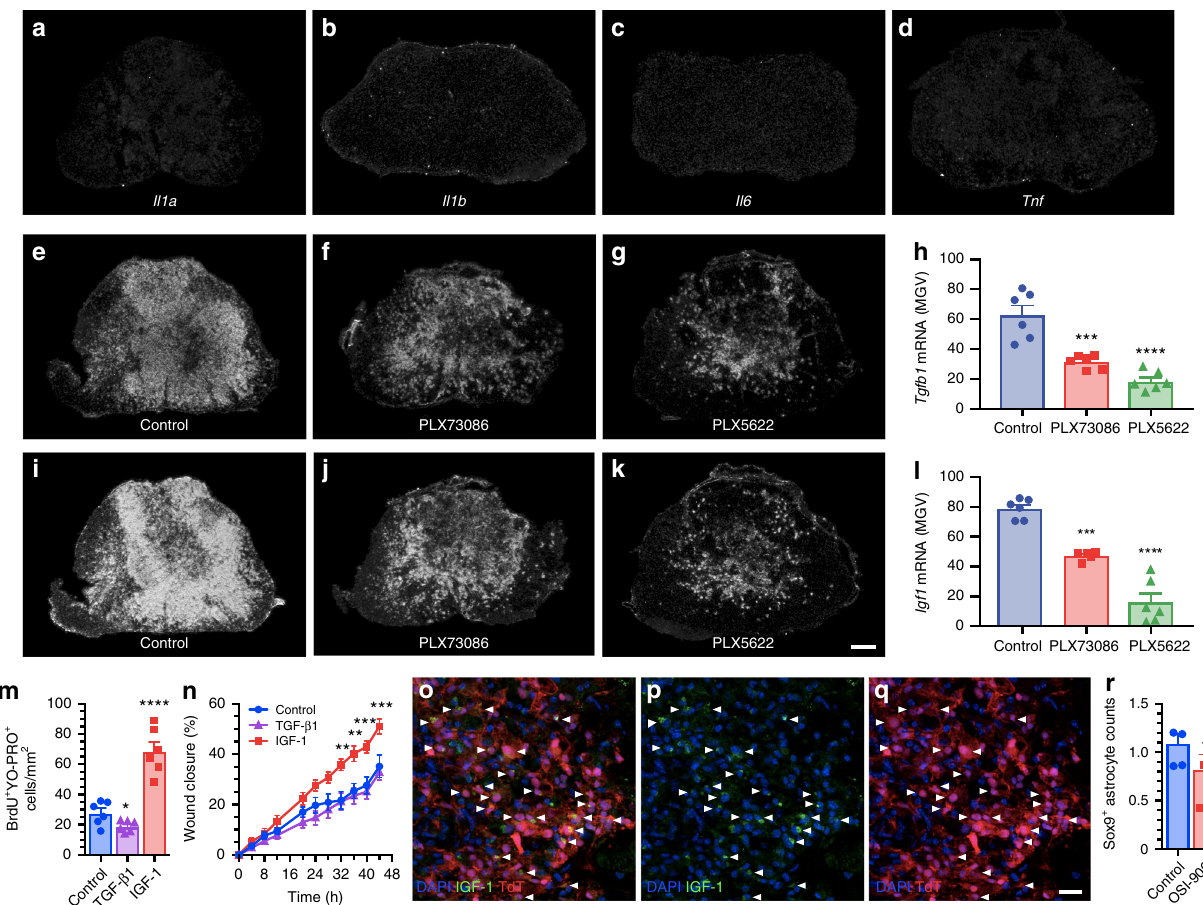
Fig. 7 Microglia-derived IGF-1 is a potent mitogen for astrocytes and inducer of astrocytic migration towards an injured area. a – d In situ hybridization (ISH) signal for the proin fl ammatory cytokines IL-1 α , IL-1 β , IL-6, and TNF in the injured mouse spinal cord (lesion epicenter) at 7 days post-SCI (dpi). e – g , i – k Representative dark fi eld photomicrographs showing expression of Tgfb1 and Igf1 mRNAs at the lesion epicenter at 7 dpi in C57BL/6 mice fed the control diet, PLX73086 or PLX5622. h , l Quanti fi cation of ISH signal (in mean grey values, MGV) for TGF- β 1 ( h ) and IGF-1 ( l ) at the lesion epicenter in mice treated with vehicle (Control, blue bars), PLX73086 (red bars) or PLX5622 (green bars) ( n = 6 per group). m Quanti fi cation of the number of BrdU + YO-PRO-1 + nuclear pro fi les following treatment of primary astrocyte cultures with either TGF- β 1, IGF-1 or control solution ( n = 6 per group). n Quanti fi cation of the wound closure response in the different groups ( n = 6 per group). o – q Representative immuno fl uorescence images showing the expression of IGF-1 (green signal, o , p ) by TdT + microglia (red cells, o and q ) accumulating at the lesion border at 7 dpi. White arrowheads indicate co-localization of IGF-1, TdT, and DAPI (blue). r Quanti fi cation of Sox9 + astrocytes, expressed as the AUC of the total number of Sox9 + cells (×10 3 per mm 3 ) from 800 µ m rostral to 800 µ m caudal to the epicenter, in the injured spinal cord of C57BL/6 mice treated with the IGF-1R antagonist OSI-906 (red bar) or the vehicle solution (Control, blue bar) ( n = 4 per group). Data are expressed as mean ± SEM. * p < 0.05, ** p < 0.01, *** p < 0.001, **** p < 0.0001, compared to the